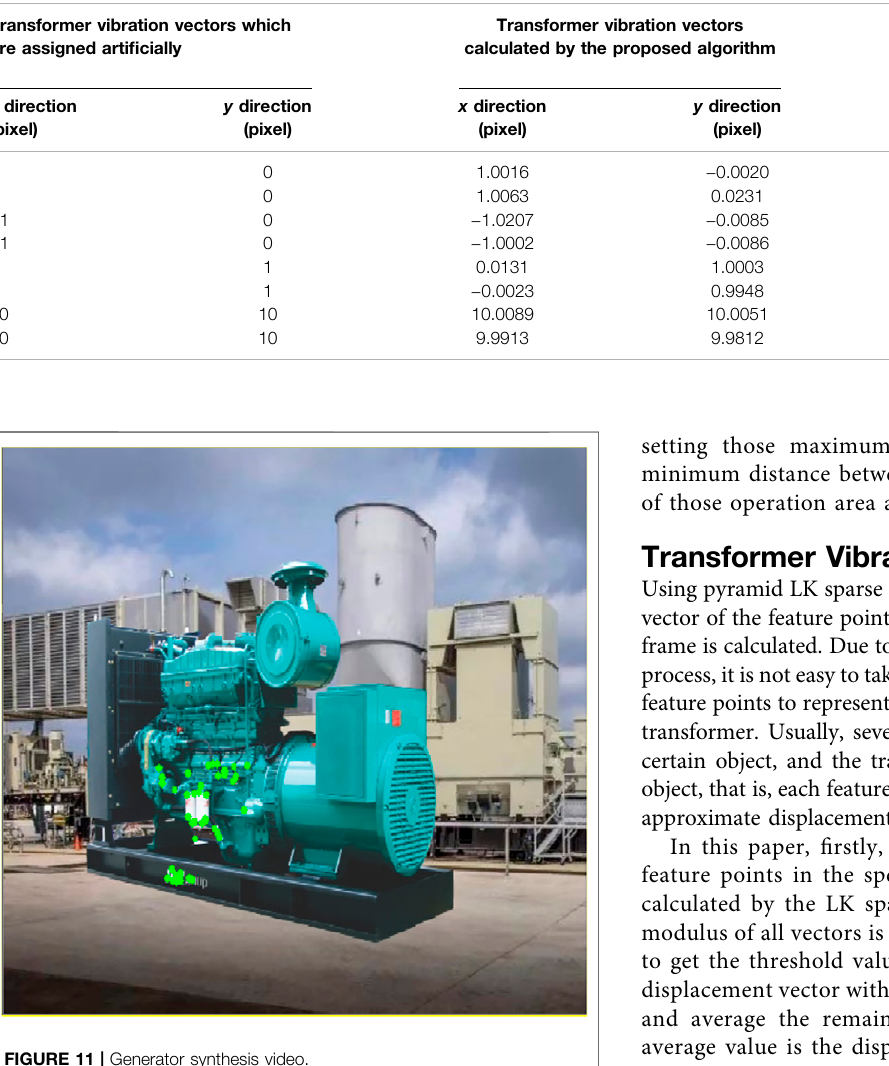
FIGURE 11 | Generator synthesis